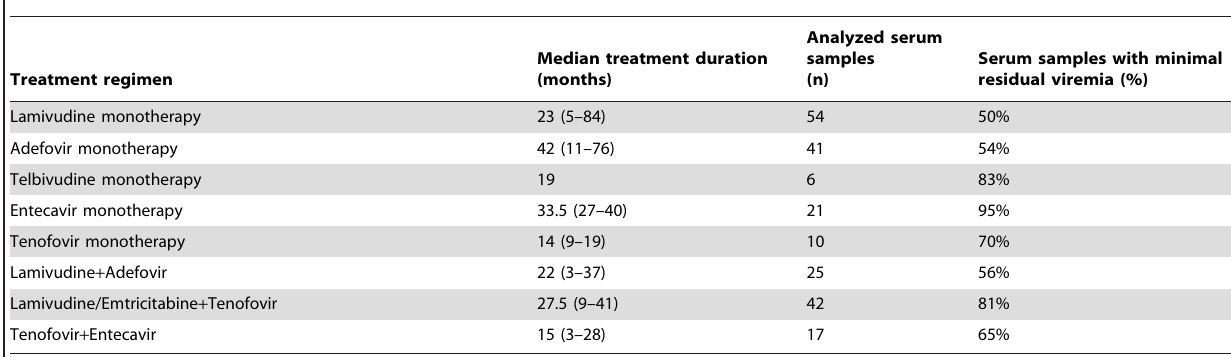
Table 2. Minimal residual viremia according to treatment